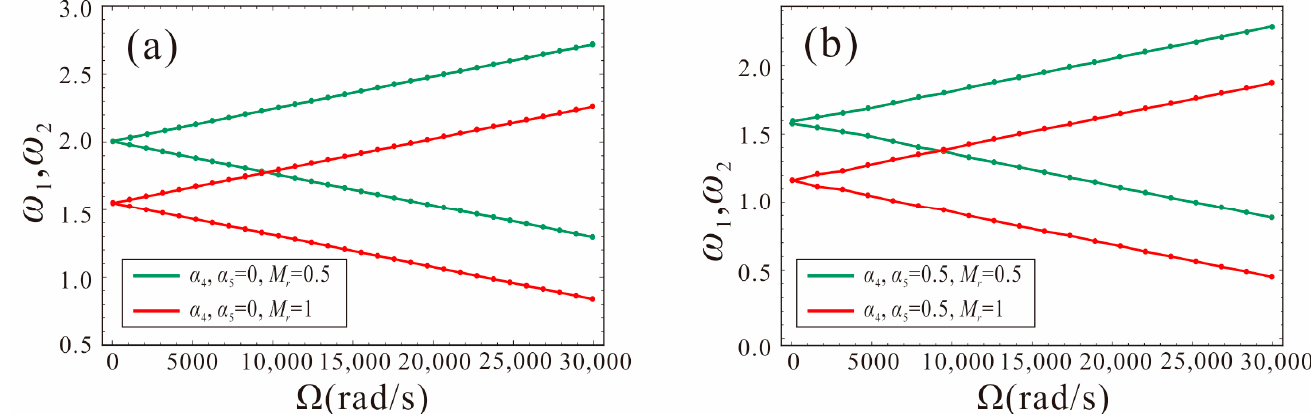
Figure 8. Variation of the natural frequency of the tapered beam micro-gyroscope with the angular velocity: ( a ) α 4 = α 5 = 0, ( b ) α 4 = α 5 =